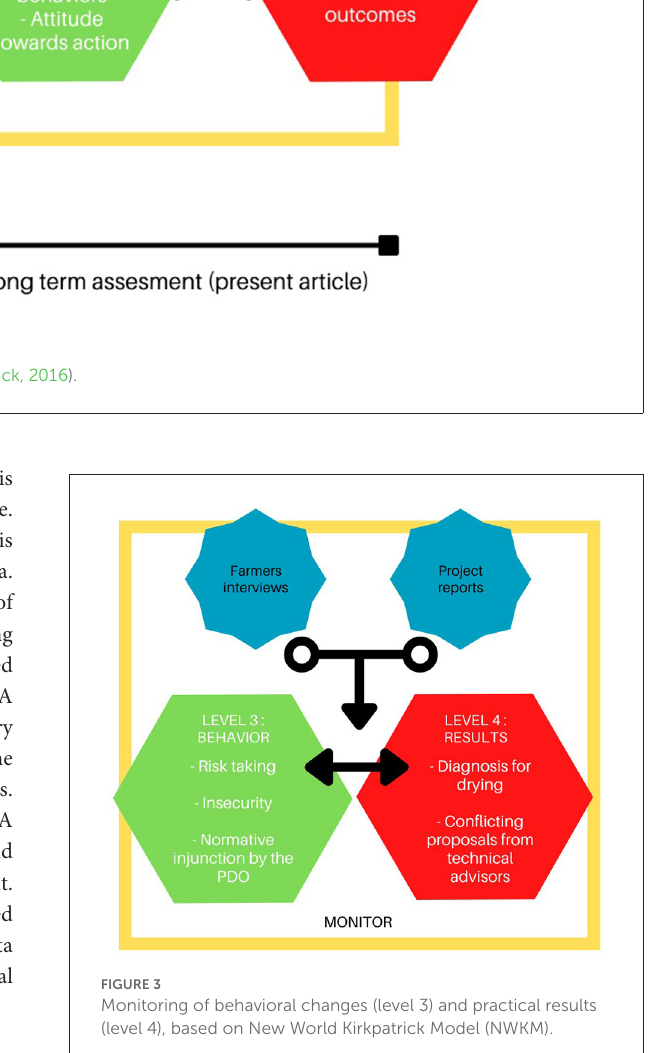
Farmers’ representations of post-prospective